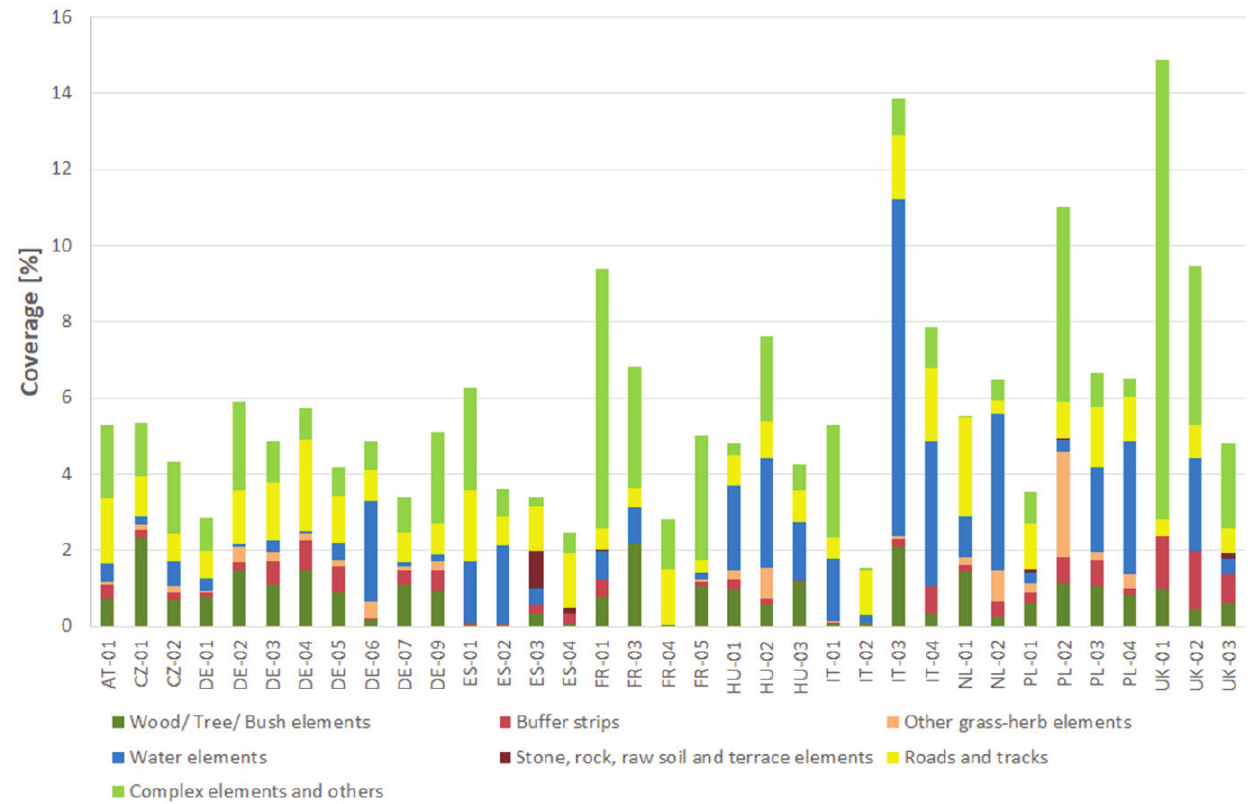
Figure 5. The coverage of different landscape elements (%) in 35 studied EU farmland regions in 2014. The figure shows both the extent and the composition of landscape element types which vary considerably across the investigated regions; thus the typical composition of landscape structure is